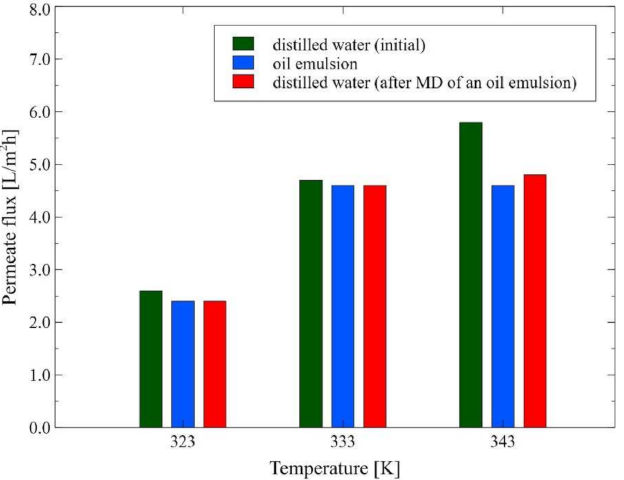
Figure 3. The impact of the feed temperature on the permeate flux. v F = 0.12 m/s. Module